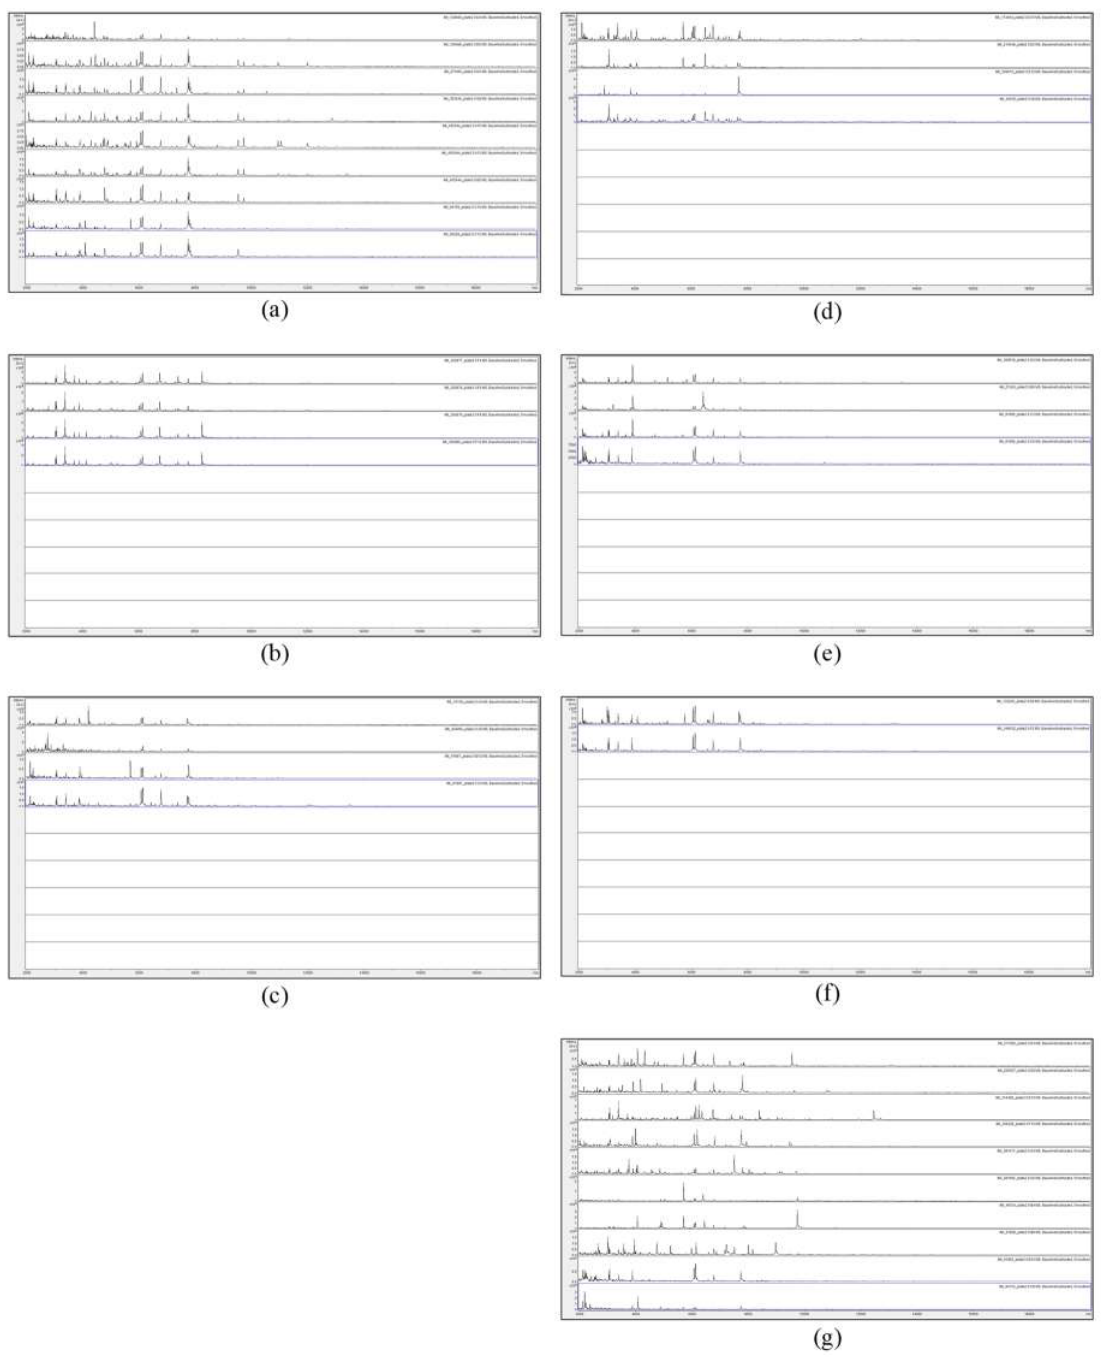
Figure 3. MALDI-TOF MS spectra of acid-soluble fungal proteins from plate-2 samples comprising ( a ) spectral-linkage group (SLG) 1, ( b ) SLG 2, ( c ) SLG 3, ( d ) SLG 4, ( e ) SLG 5, ( f ) SLG 6, and ( g ) spectrally-unique samples (SUSs).